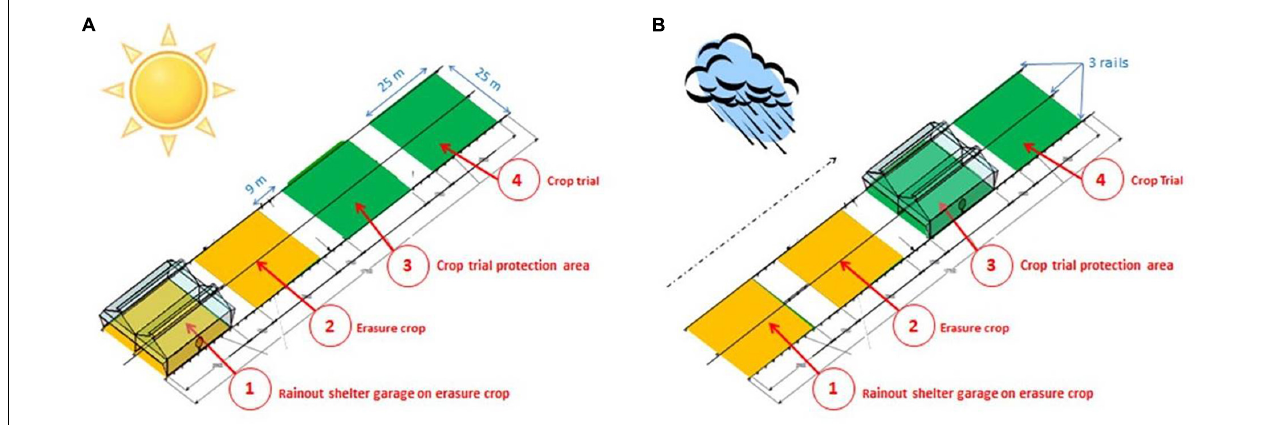
FIGURE 2 | Four crop growth areas to ensure a correct crop rotation every year (switch between green area and yellow area) and to avoid the effects of drop shadows on the crop trial (at least 35 m). (A) No rain position; (B) position during a raining